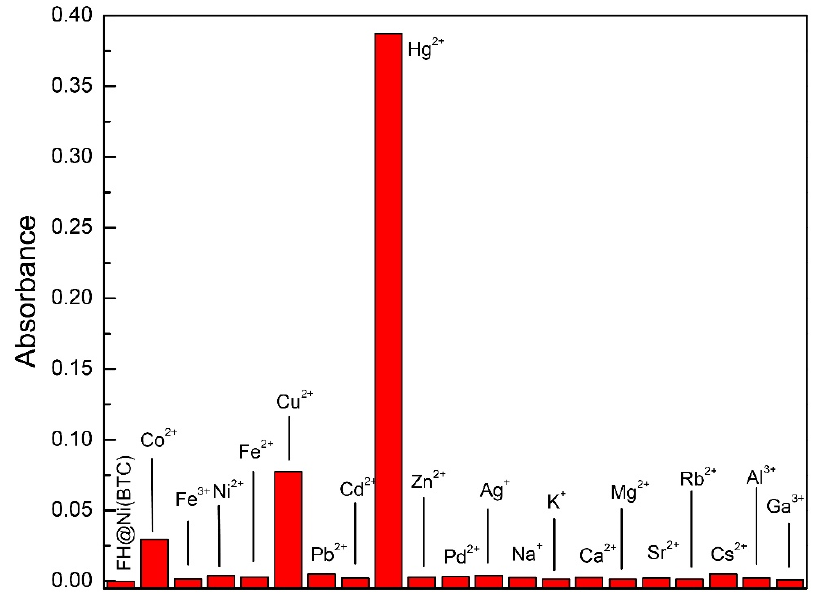
Figure 4. Change in the UV–vis absorbance of FH@Ni(MOF) in water upon addition of 200 μ L of different metal cations (10 − 2 M).